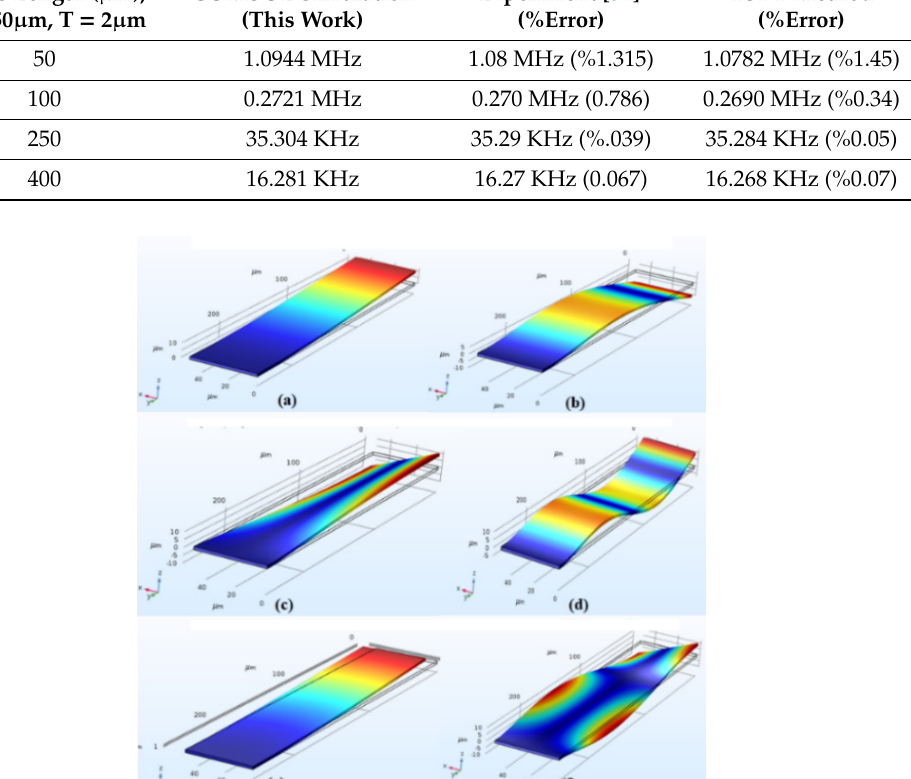
Figure 7. The frequency responses calculated with TSBT method for microcantilevers with W = 50 µm, T = 2 µm and L = 50, 100, 250 and 400 µm. According to the simulation results, analytical data, and considering experimental results, it is evident that COMSOL has enough accuracy to do other analyses and achieve the AbFM parameters. There are important contributory factors in AbFM design such as (1) the vertical distance between